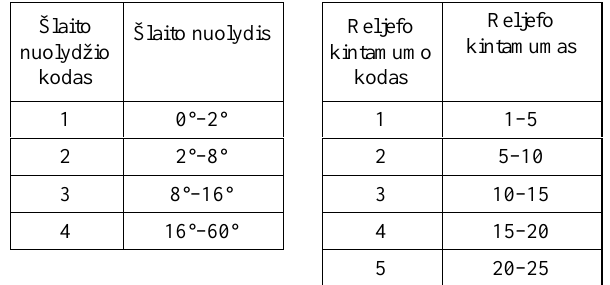
Table 4. Relief slope and variability classification